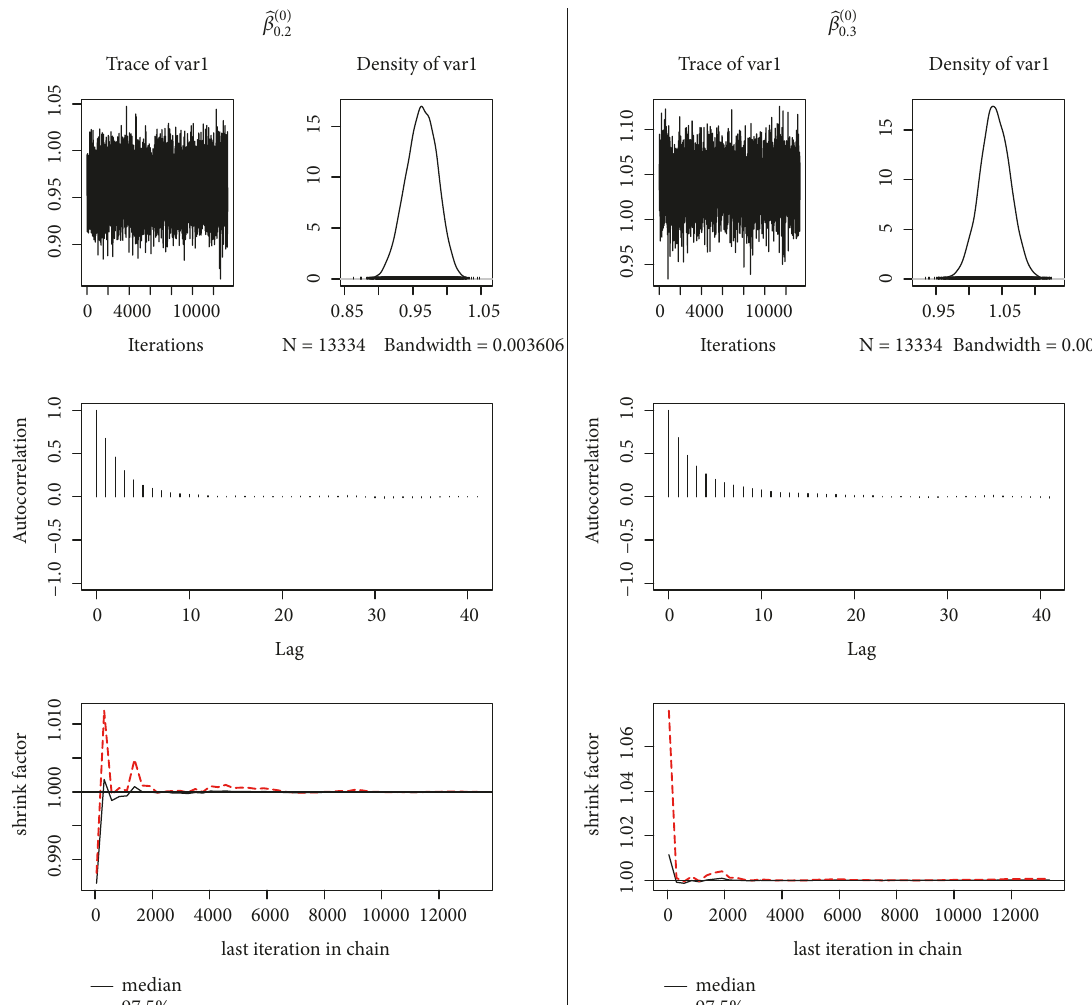
̂𝛽 (0) 0.2 (left panel) and the slope